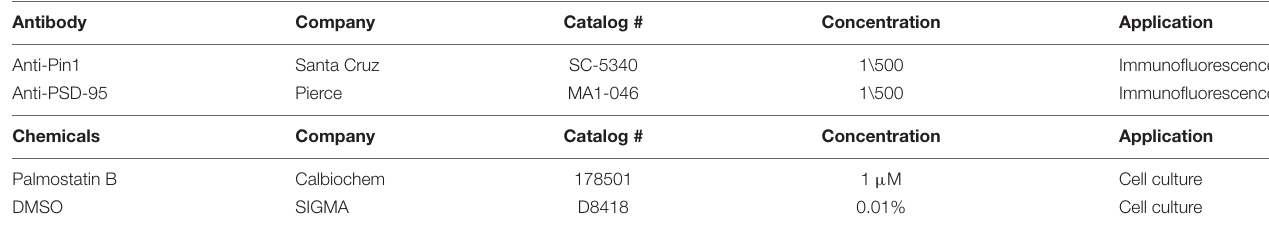
TABLE 1 | Antibody/drug